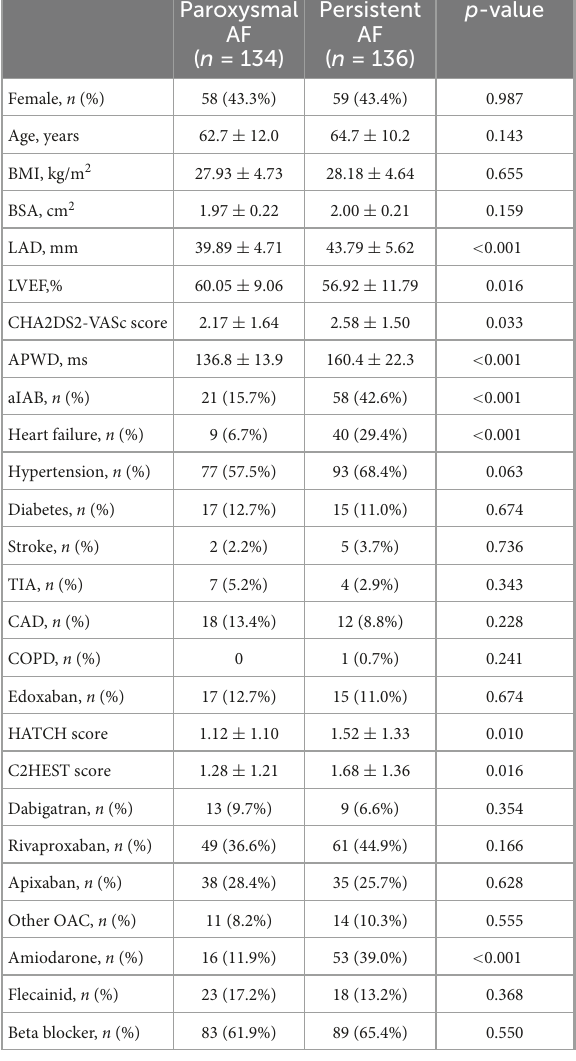
TABLE 1 Baseline characteristics between paroxysmal AF and persistent AF